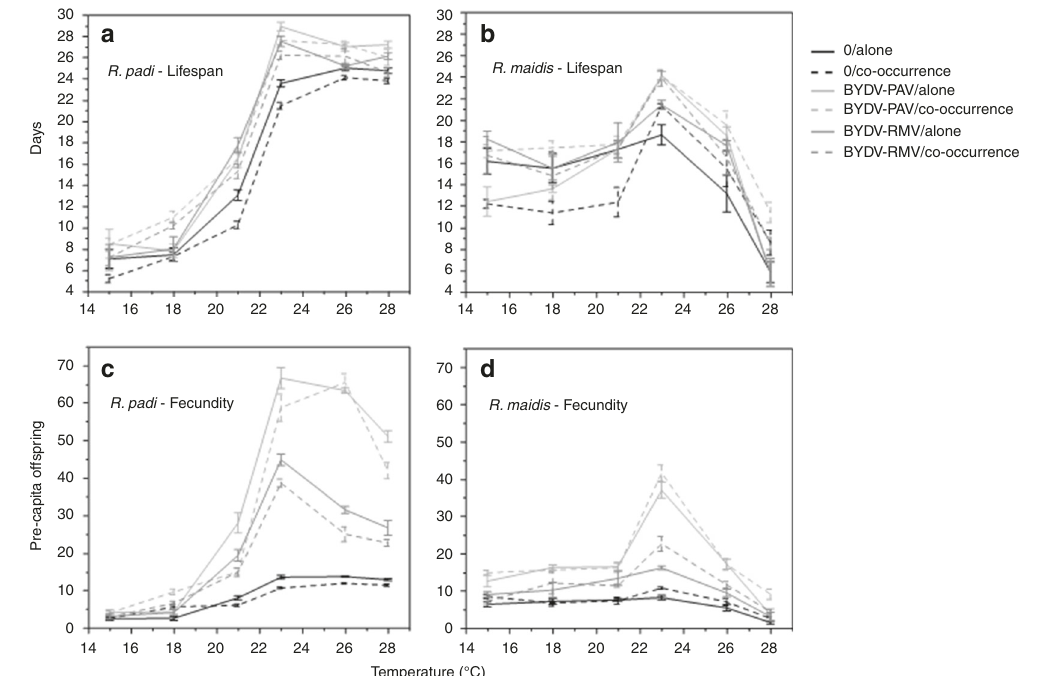
Fig. 5 Temperature and viral infection in fl uence lifespan and fecundity of aphid species. Performance curves of lifespan ( a , b ) and fecundity ( c , d ) of R. padi and R. maidis , alone or co-occurring with other aphid species, on plants infected with BYDV-PAV or BYDV-RMV and on virus-free plants across a range of environmental temperatures. Rhopalosiphum padi transmits BYDV-PAV, while R. maidis transmits BYDV-RMV (mean ± SE per treatment per temperature; n = 15 per treatment). Source data are provided as a Source data fi